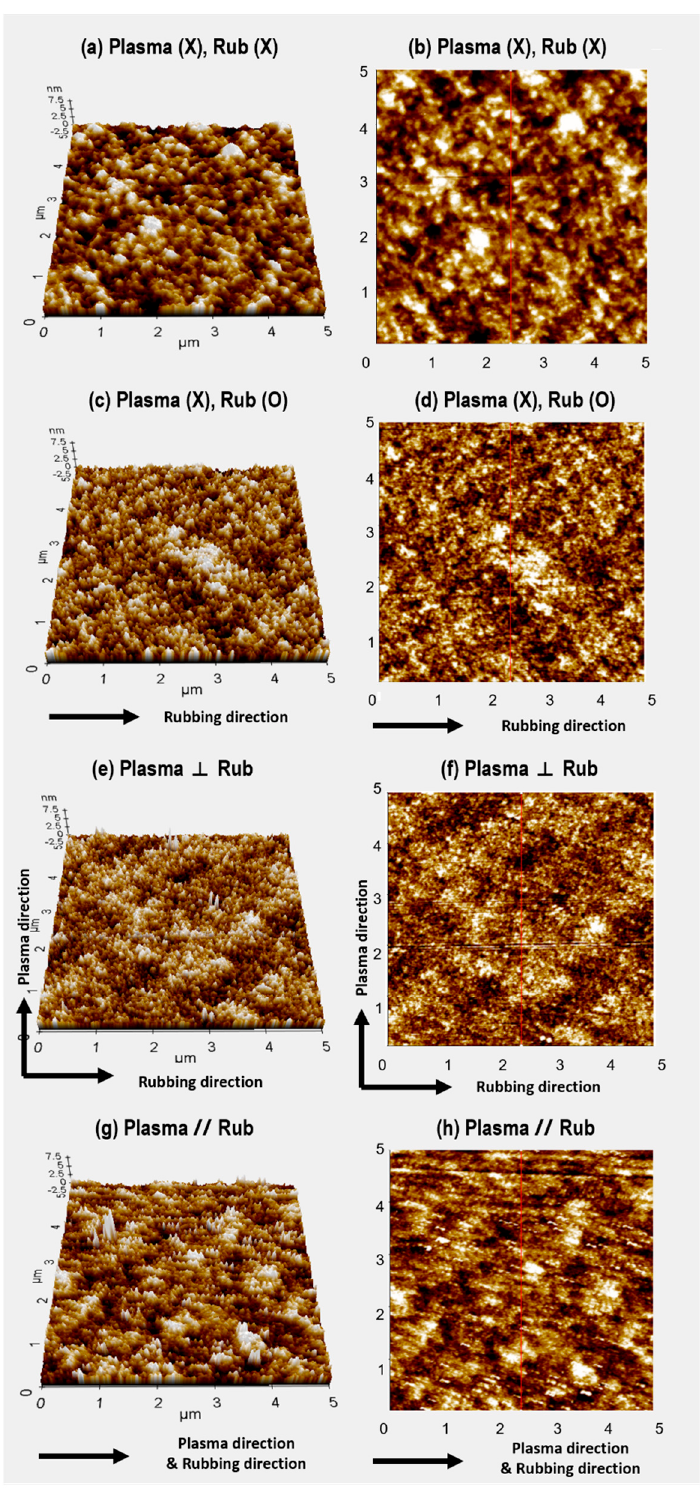
Figure 11. AFM surface topography of the PVA surface with various surface treatment conditions. ( a , b ) No plasma treatment and no rubbing, ( c , d ) no plasma treatment and rubbing, ( e , f ) plasma treatment perpendicular to the rubbing, ( g , h ) plasma treatment parallel to the rubbing. ( a , c , e , g ) are three-dimensional top-view images, and ( b , d , f , h ) are two-dimensional oblique-view images.